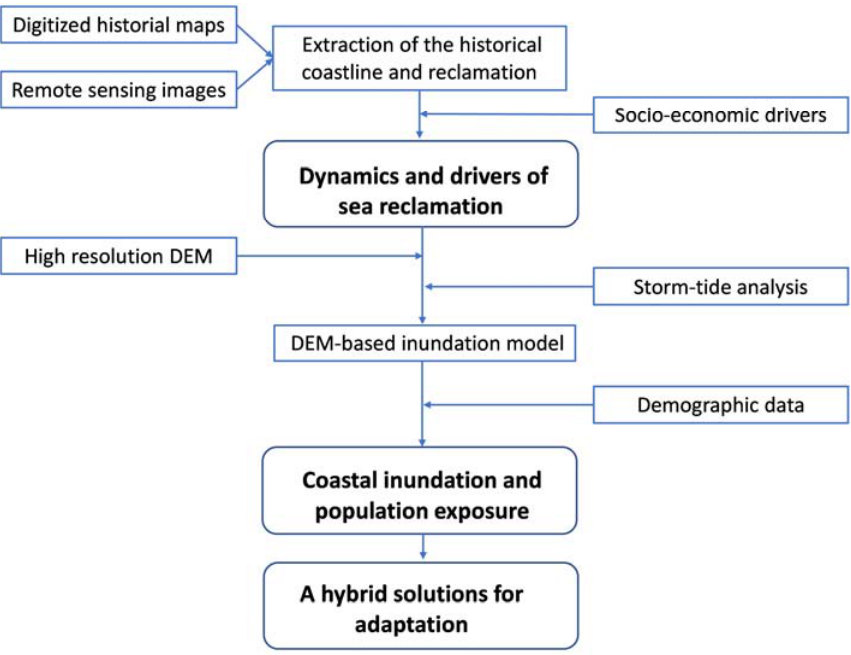
Figure 2. Flowchart showing the methodology of the study .